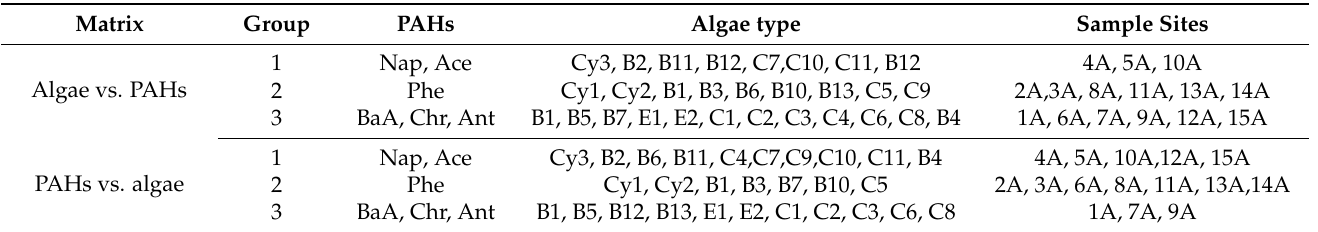
Table 4. Summary about the relationship among residual PAHs, indicator algae, and sampling sites in